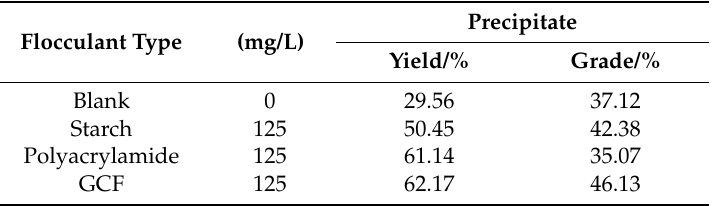
Table 1. Effects of different flocculants on selective flocculation.